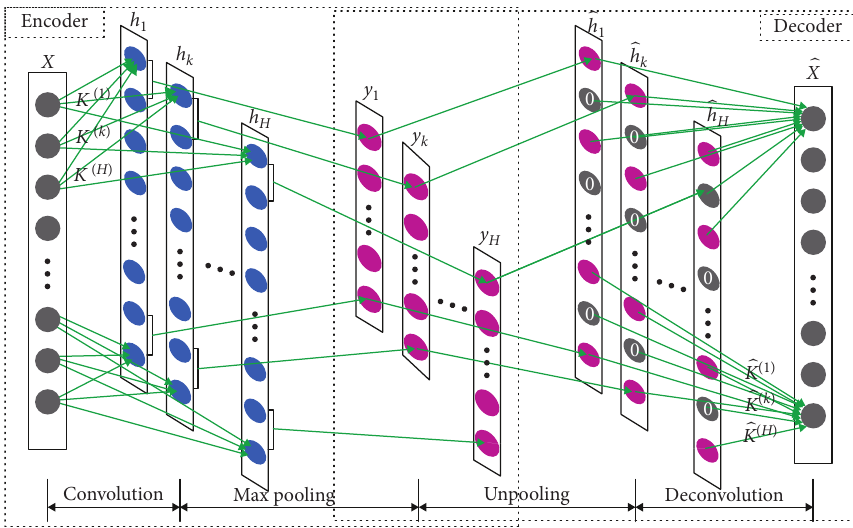
Figure 1: Structure of